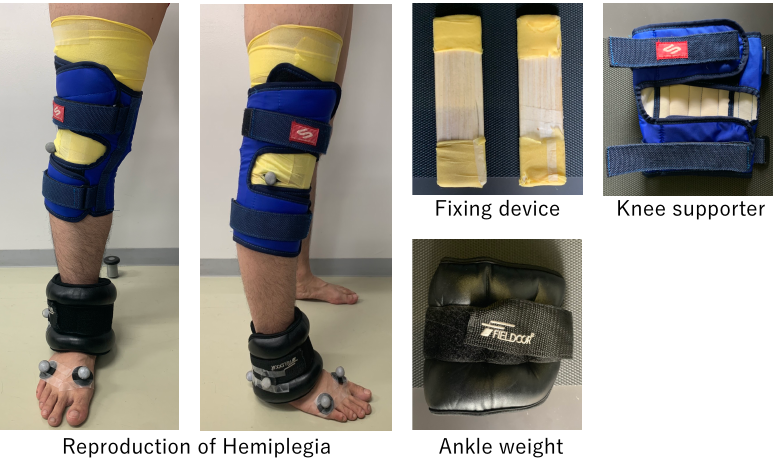
Figure 2. The reproduction of the hemiplegia by restricted the knee joint motion and a load of 3 kg on the ankle